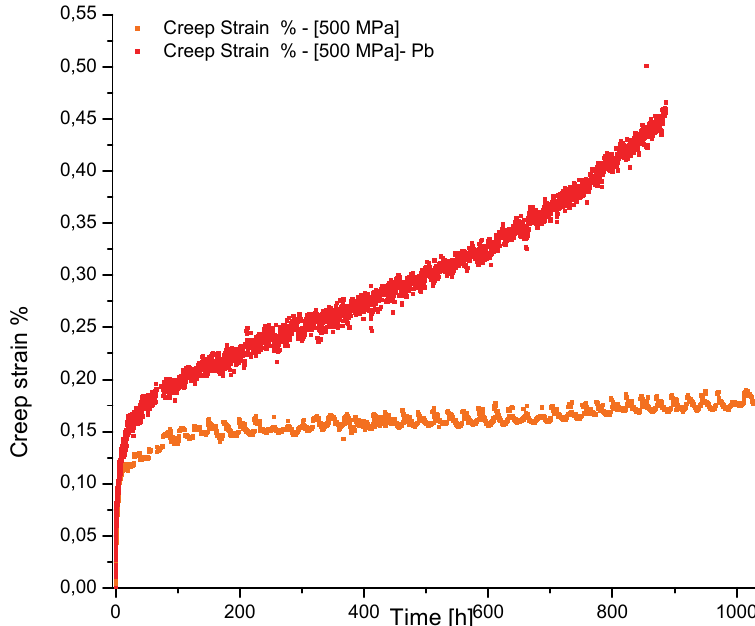
Figure 12: Comparison between creep curves 500MPa in air and in